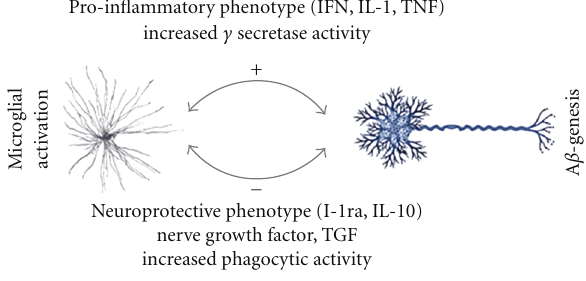
Figure 1: Schematic depiction of the beneficial and detrimental e ff ects of the interaction A β -genesis and microglia after traumatic brain